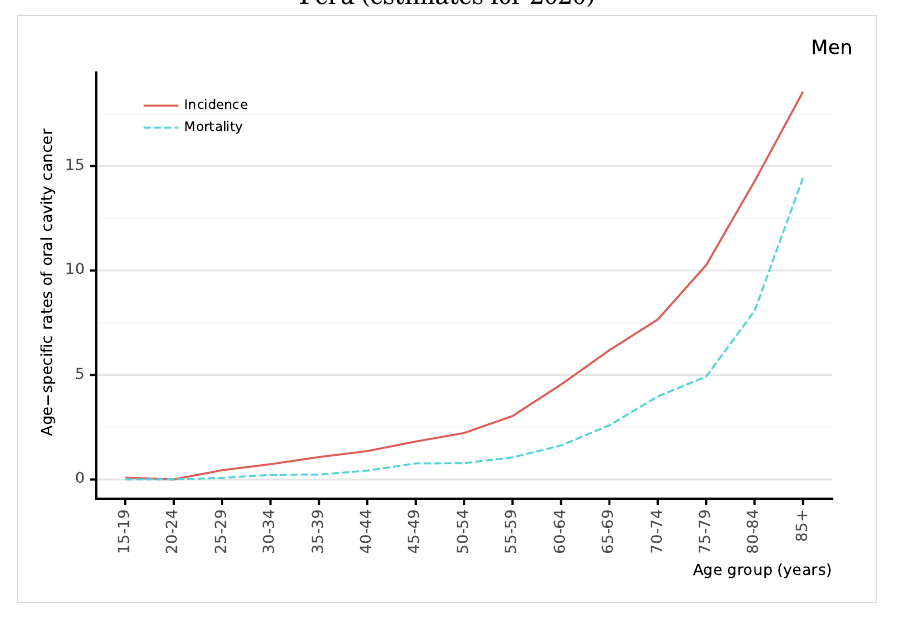
Figure 46: Comparison of age-specific oral cavity cancer incidence and mortality rates among men in